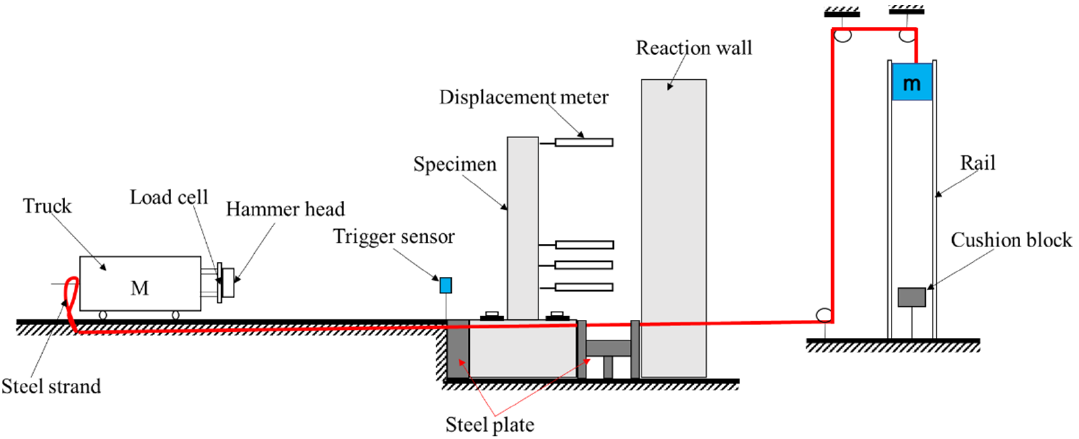
Table 1. Detailed parameters of test specimens.